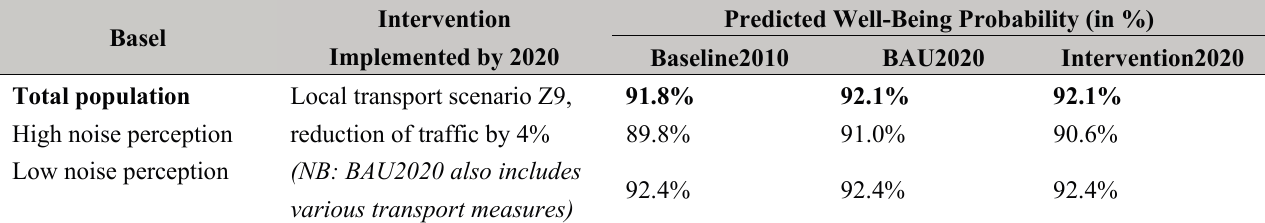
Table 7. Well-being probability in Basel by noise levels.